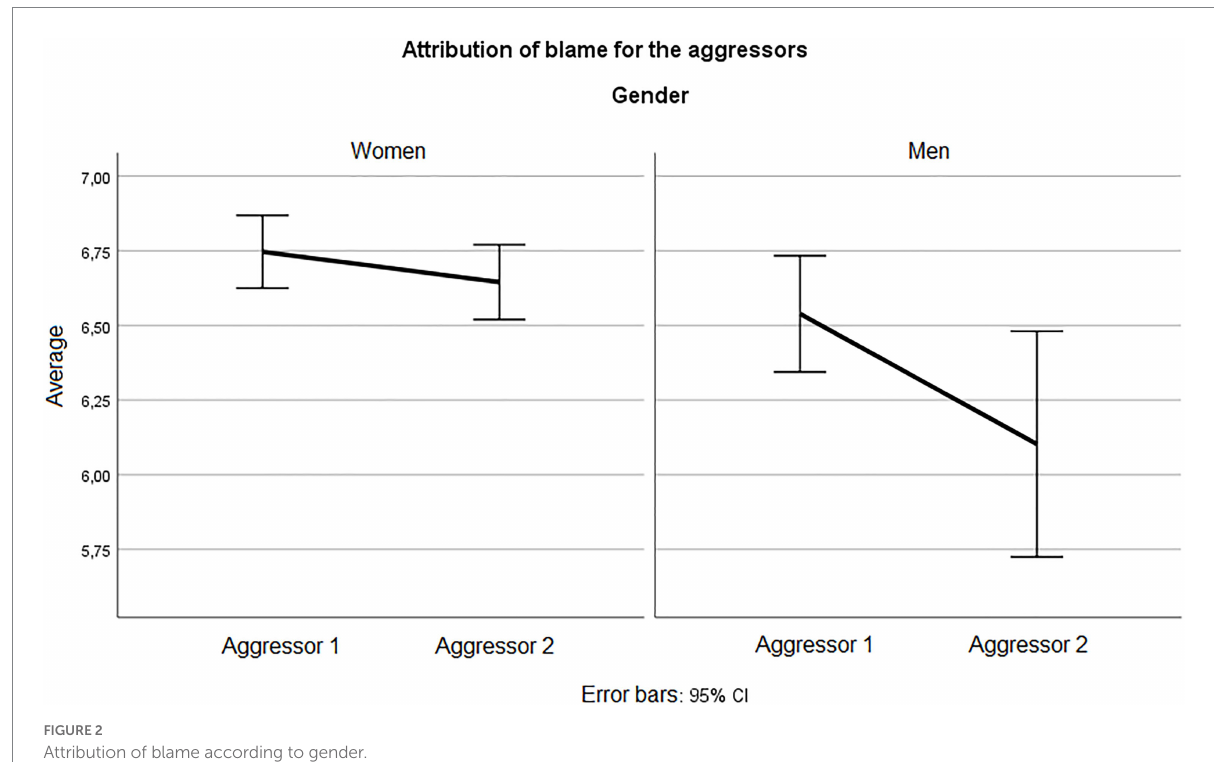
FIGURE 2 Attribution of blame according to